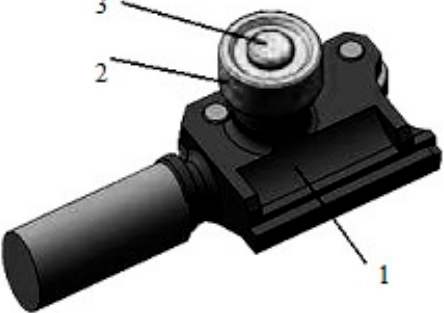
Figure 2. Cam transmission mechanism. Note: 1—fixed cam curve slot, 2—main roller, 3—bolt group, and 4—revolving body.